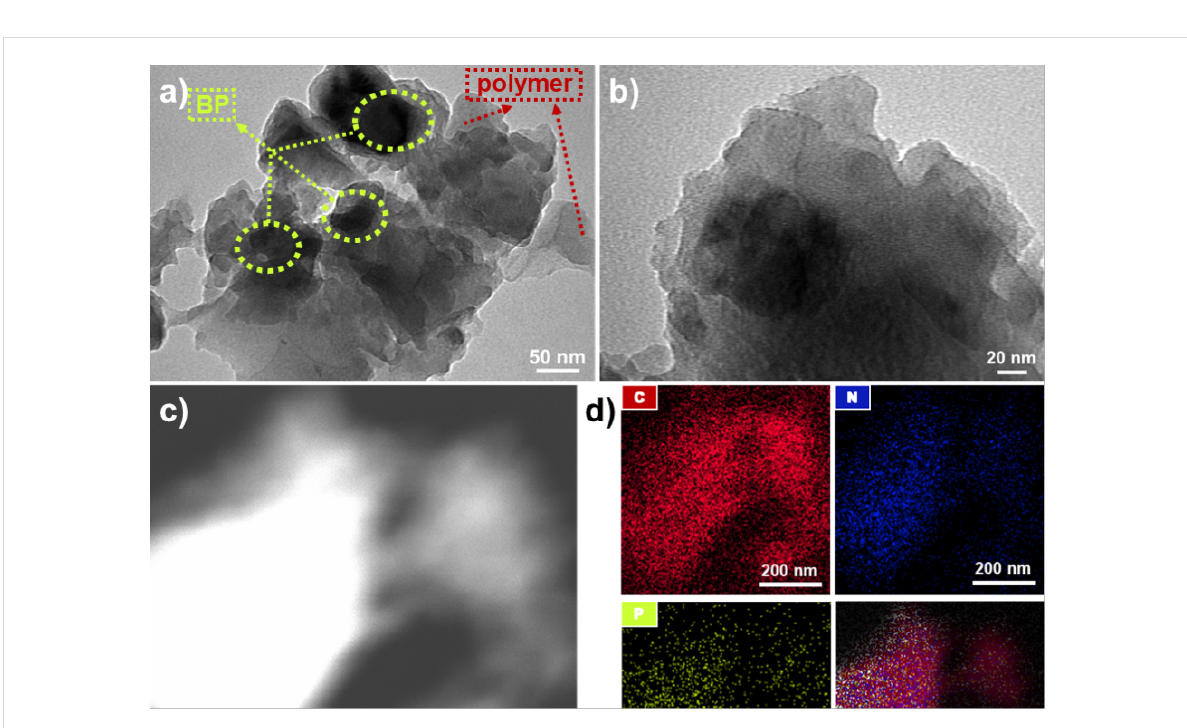
Figure 7: (a, b) TEM images of cross-linked polymer at two different magnifications, c) HAADF-STEM image and d) the associated EDS elemental mapping images of the cross-linked